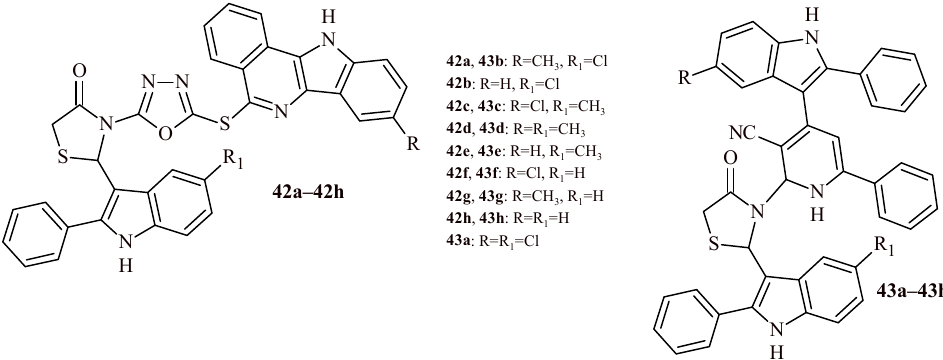
Figure 18. The structures of a series of thiazolidin-4-one-1,3,4-oxadiazoles ( 42a – 42h ) and thiazolidin-4-one with indolyl-pyridine moiety ( 43a – 43h ).